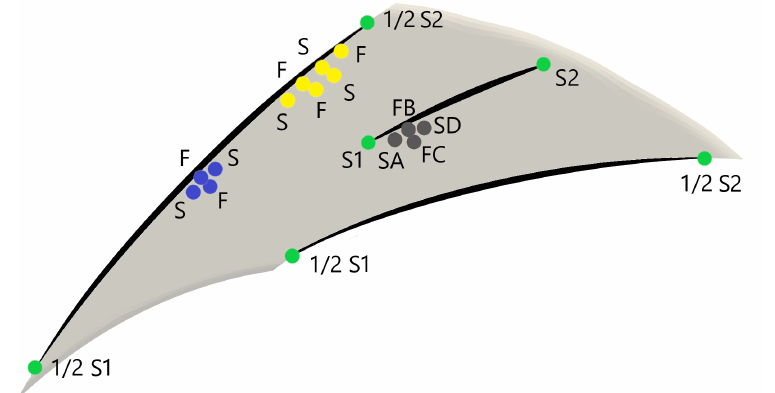
Figure 9. Location of the different critical points on the hub